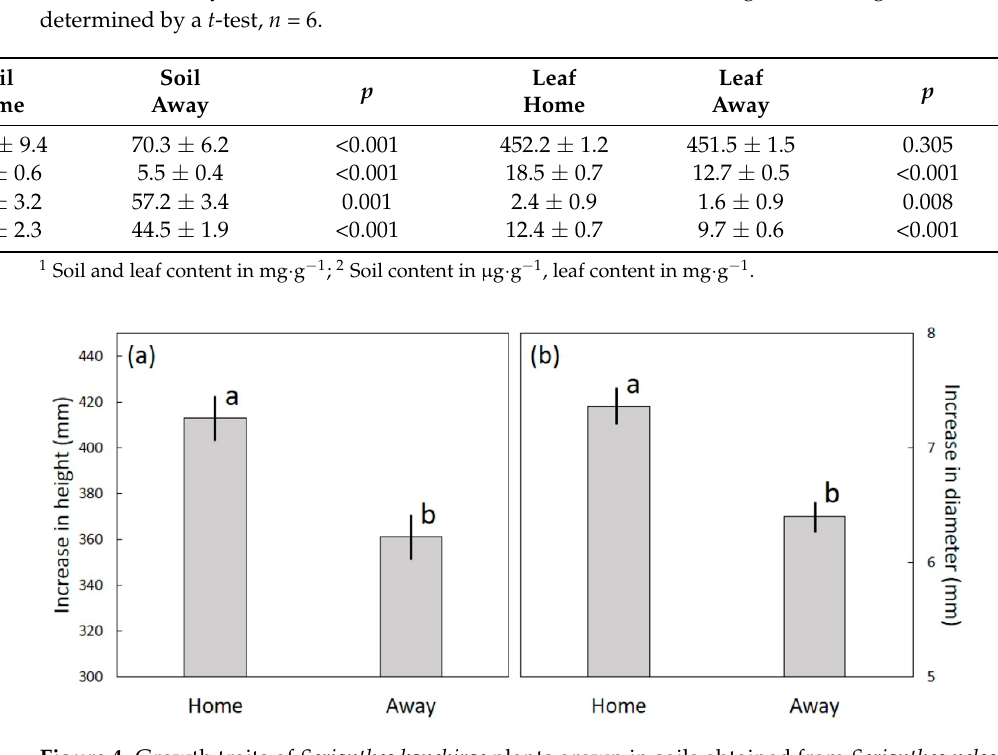
Figure 4. Growth traits of Serianthes kanehirae plants grown in soils obtained from Serianthes nelsonii rhizosphere (Home) and from soils 50 ─ 70 m away (Away). ( a ) Increase in plant height. ( b ) Increase in basal stem diameter. Mean ± SE, n = 6. Columns with different letters are significantly different, according to a t -test.